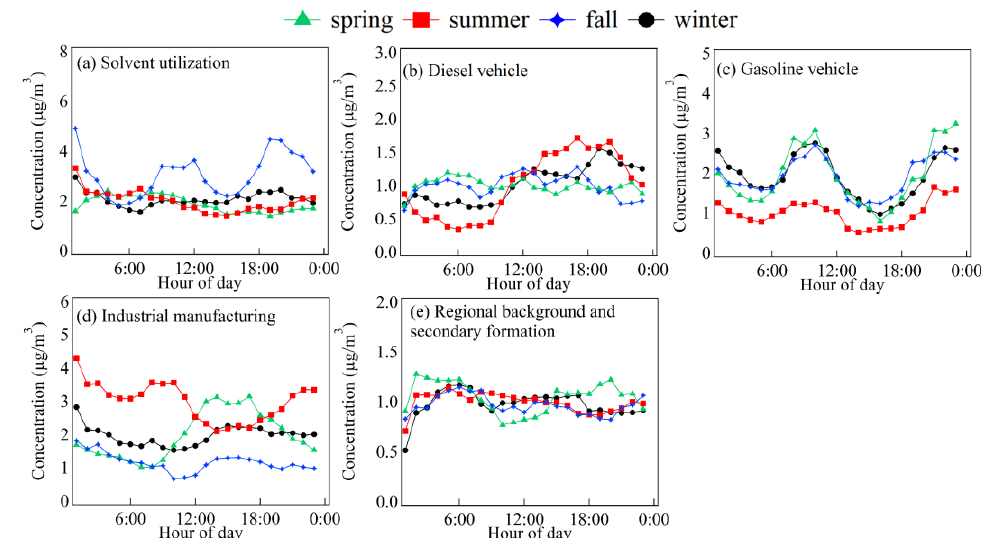
Figure 11. Diurnal variation of the contribution of VOC emissions contributed by the five iden- tified VOC sources: ( a ) solvent utilization; ( b ) diesel vehicle; ( c ) gasoline vehicle; ( d ) industrial manufacturing; and ( e ) regional background and secondary